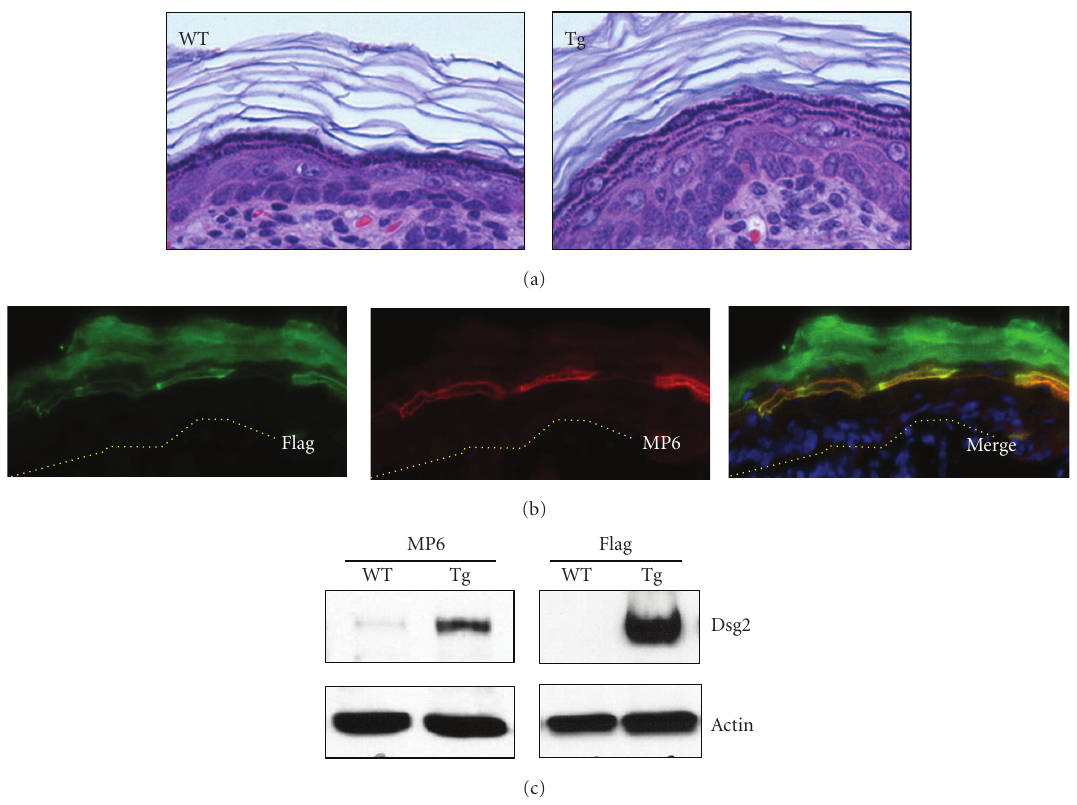
Figure 1: Suprabasal expression of Dsg2-Flag in newborn Inv-Dsg2 transgenic mice. (a) Histology showing slight epidermal hyperplasia in a newborn Inv-Dsg2 Tg overexpressing Dsg2 in the superficial epidermis under the involucrin promoter, but not in WT mice. (b) Immunostaining of newborn Tg skin with Flag (green) and Dsg2-specific MP6 (red) antibodies showing expression of Dsg2-Flag in the di ff erentiated cell layers of the transgenic epidermis. (c) Immunoblot of WT and Tg skin with MP6 and Flag antibodies, showing Dsg2-Flag in the Tg but not WT skin. Actin was used for equal